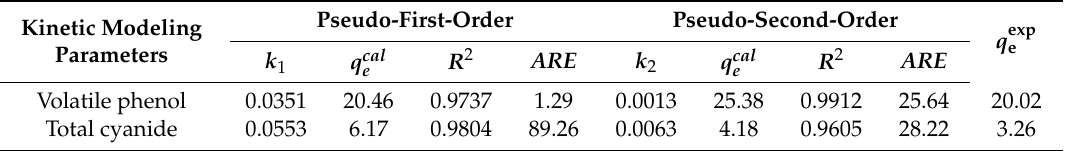
Table 4. Parameters of kinetic modeling of the adsorption of volatile phenol and total cyanide onto SBAC.